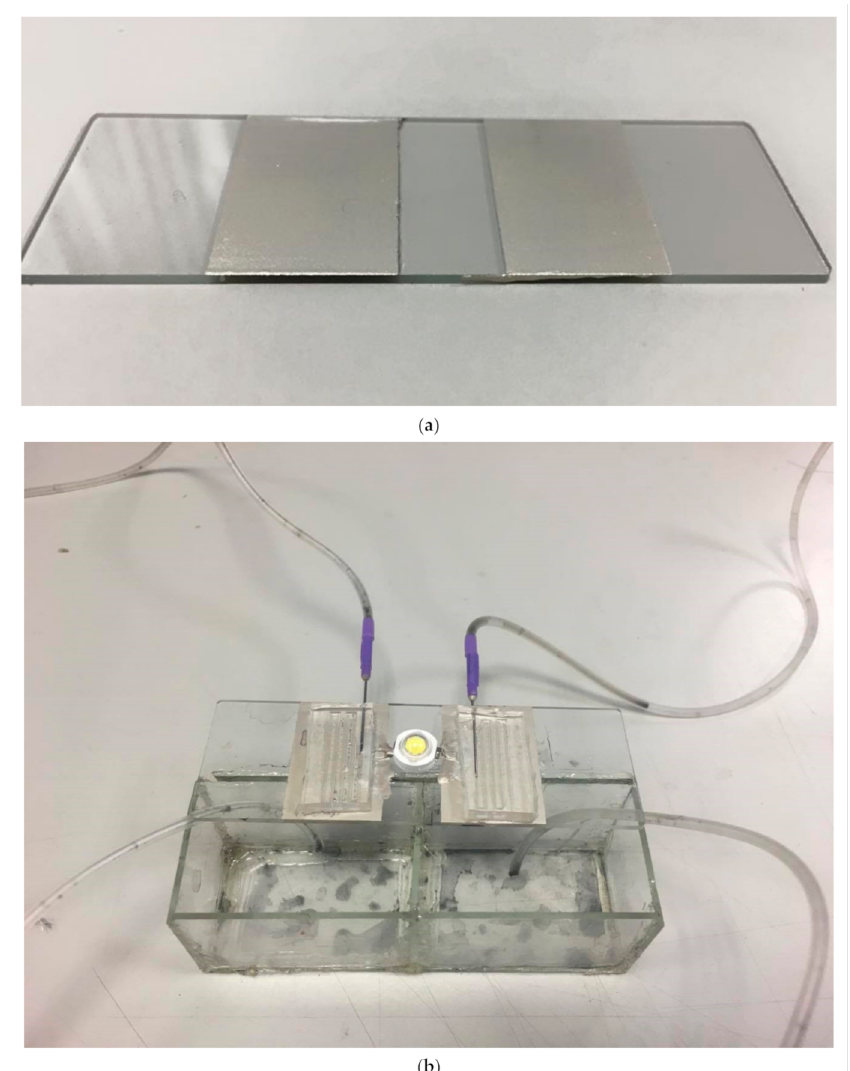
Figure 3. Schematics of the system: ( a ) image of the microscope slide with silver adhesive; ( b ) image of the LED with a liquid circulating